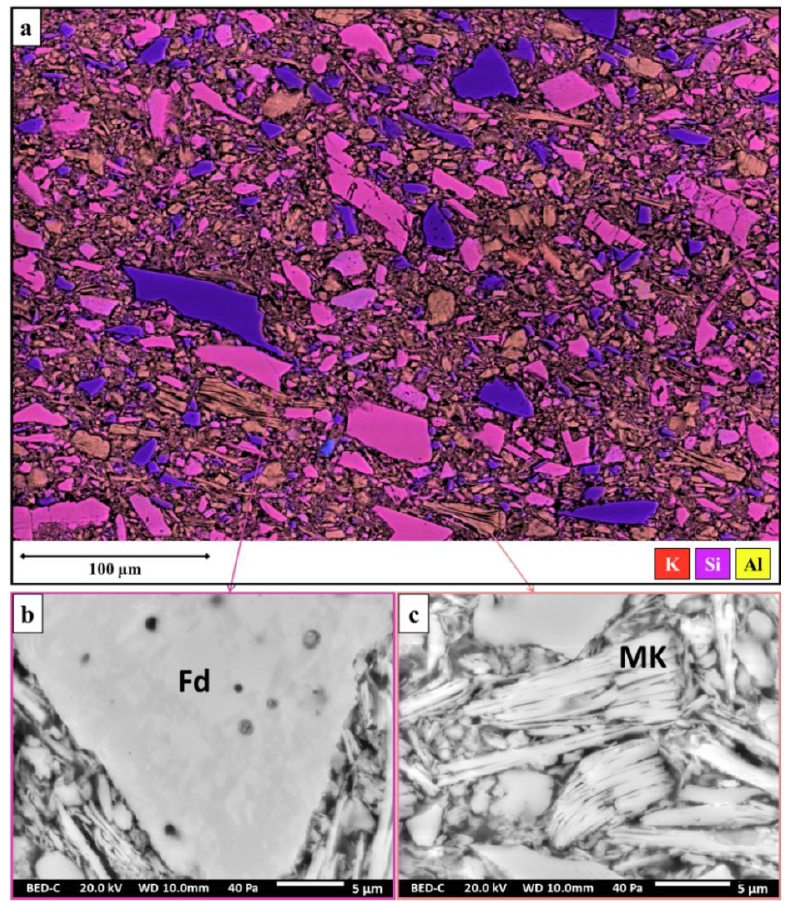
Figure 2. ( a ) Elemental mapping of biscuit body obtained by SEM-EDS and SEM backscattered electron images of ( b ) K-feldspar (Fd) and ( c ) coarse meta-kaolinite flake (MK) present in biscuit.